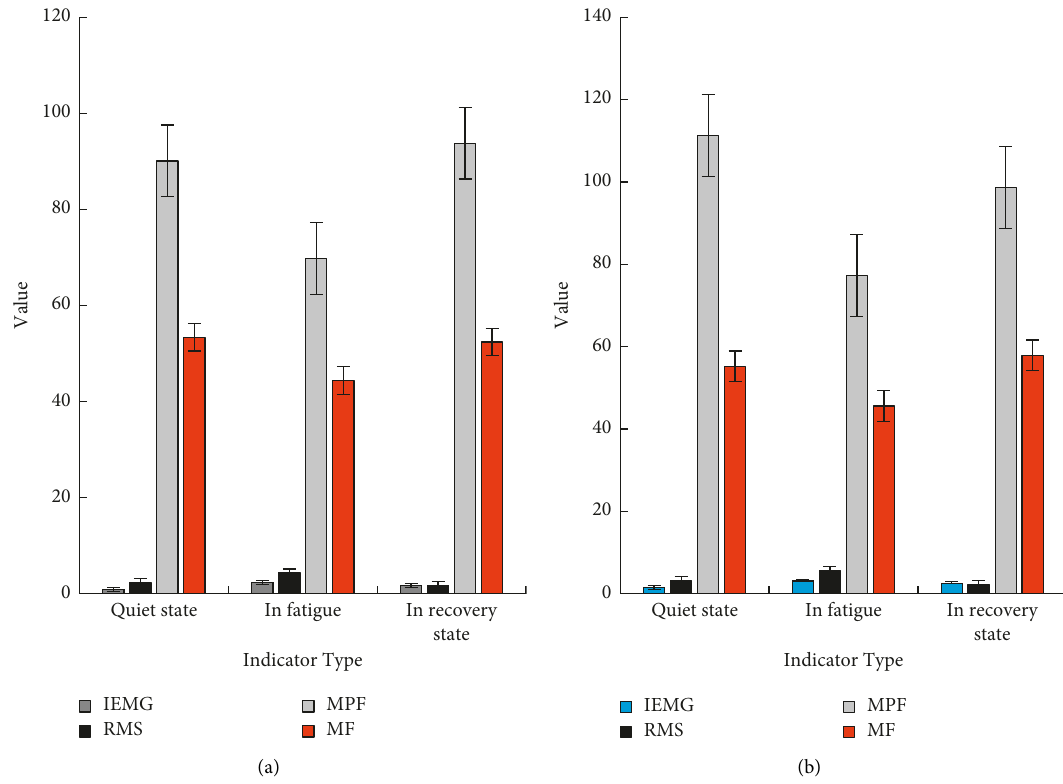
Figure 7: Mean change in sEMG data ( μ V) of subjects in quiet, fatigued, and recovering states: (a) normal group and (b) experimental